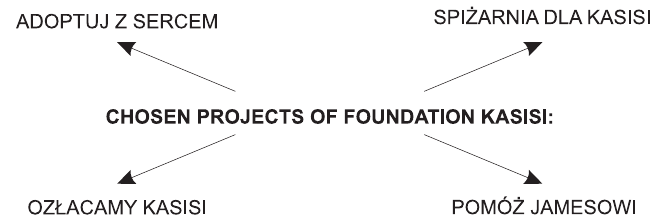
Figure 3. Selected projects implemented by the Kasisi foundation